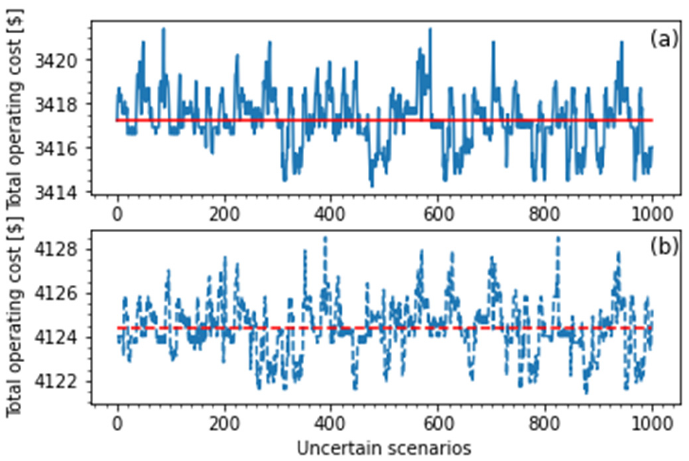
Figure 8. Effect of voltage-based DR on DCM’s operating cost: ( a ) with voltage-based DB; ( b ) without voltage-based DR.